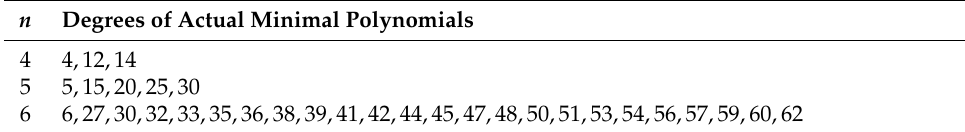
Table 1. The degrees of actual minimal polynomials of modified de Bruijn sequences of order n ∈ { 4,5,6 } , reproduced from